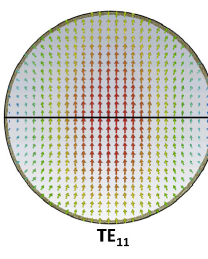
FIG. 6. First mode propagating inside the cylindrical wave- guide with a slab placed in the center.